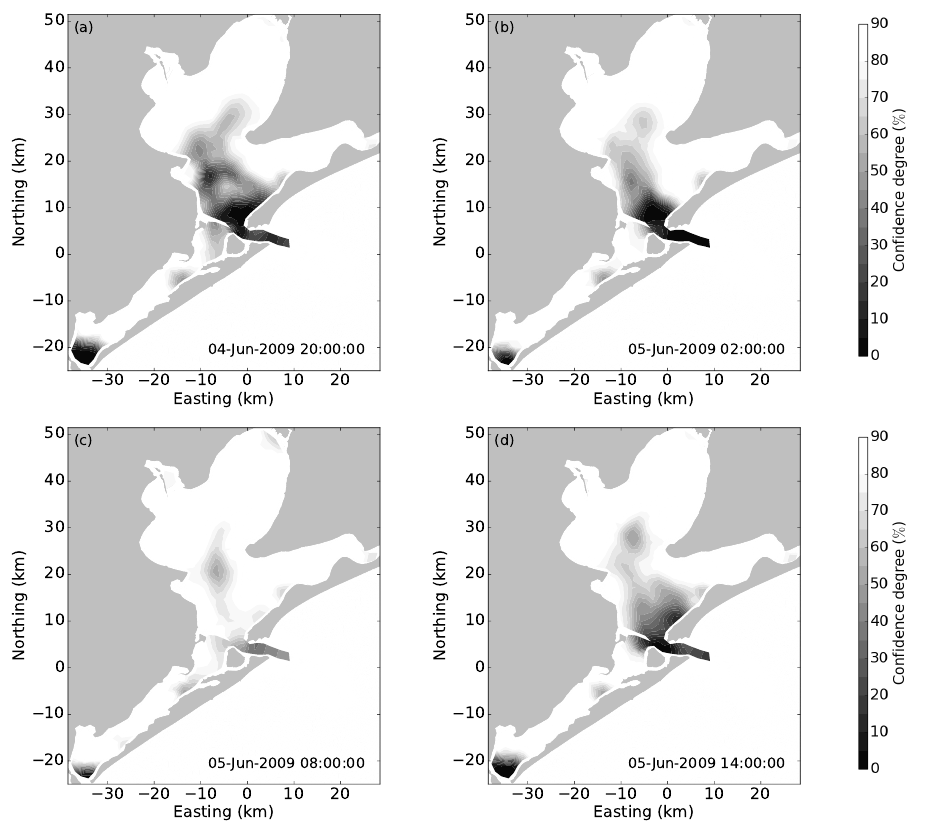
Figure 6. The spatial distribution of confidence ( C ) at four flow conditions: ( a ) maximum flood tide, ( b ) moderate flood tide, ( c ) weak ebb tide (near slack water), and ( d ) maximum ebb tide. Note the color scale is inverted so that low confidence is dark grey, which is consistent with large separation and diffusion errors in Figures 4 and